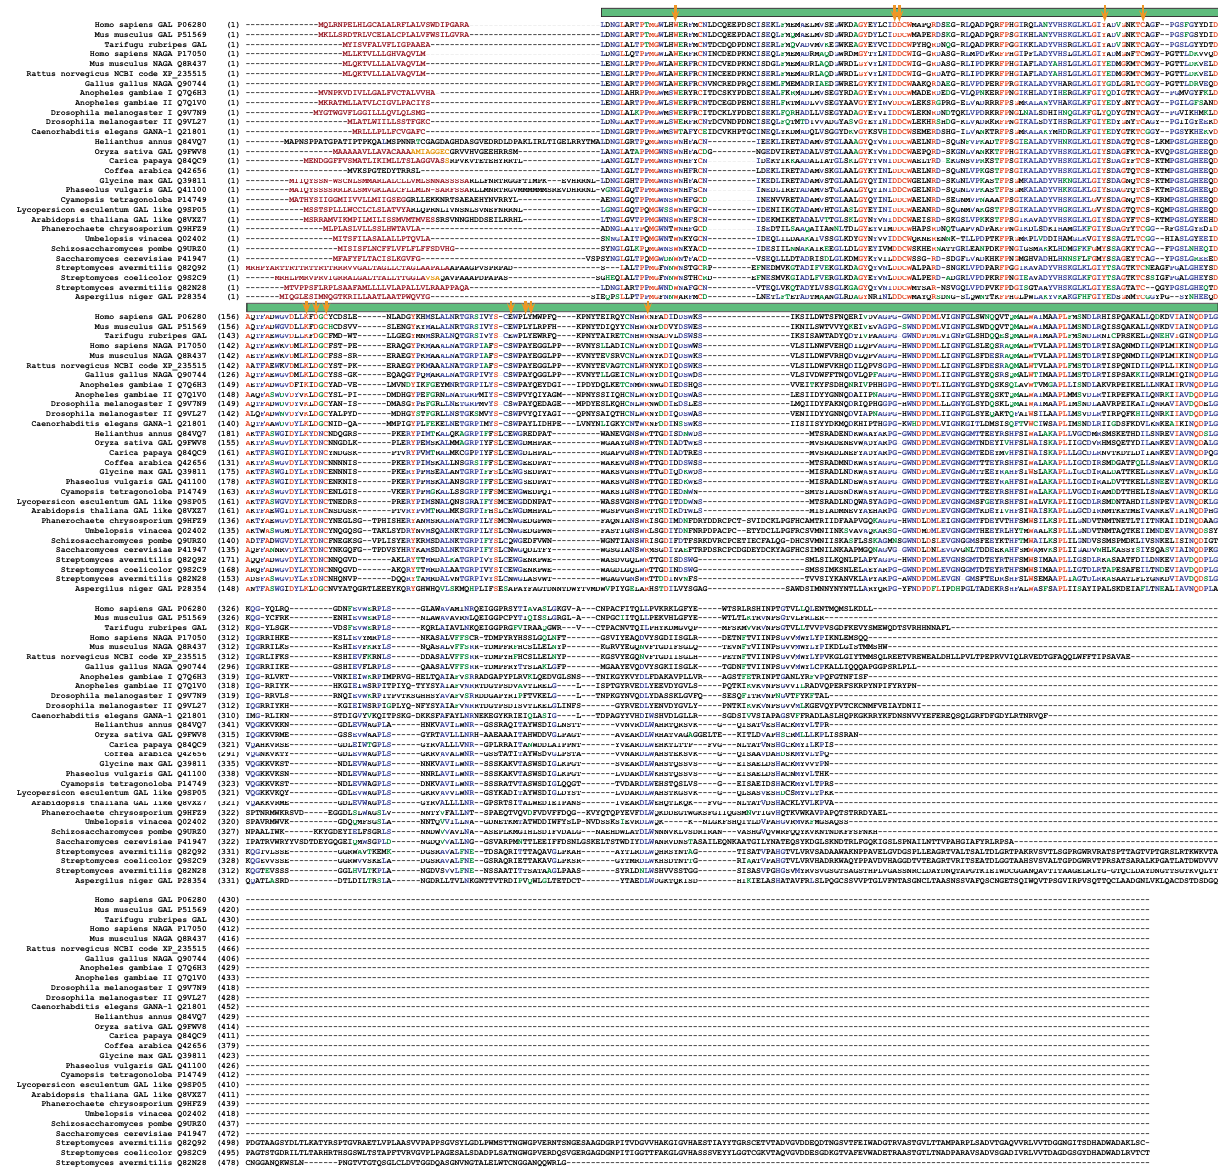
Multiple alignment Figure 2 Multiple alignment. Multiple alignment of 29 sequences homologous with GANA-1. These sequences represent animal, plant and protozoan kingdoms. The SwissProt/TrEMBL codes are part of the sequence names. Predicted signal peptides are shown in brown letters. In cases where two signal sequence prediction algorithms gave different results the difference is marked by amber color. The residues forming active site pocket of GANA-1 are indicated by arrowheads above the alignment. The catalytic domain I is indicated by green band above the